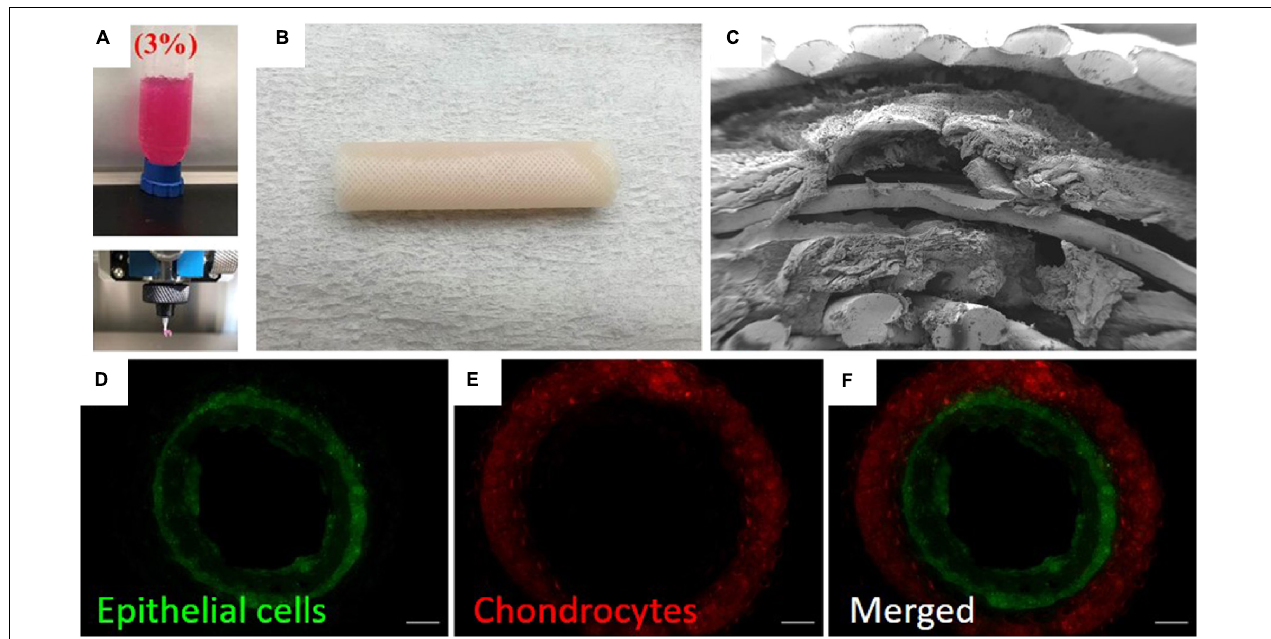
FIGURE 6 | Example of 3D printing process for construction of tissue engineered trachea (Park et al., 2019). (A) Image showing 3D printing of alginate into a cell-compatible hydrogel. (B) Image of 3D printed trachea. Scaffold consisted of 5 layers (innermost to outermost): gridded pattern of poly(capralactone), alginate hydrogel containing primary nasal epithelial cells, cylindrical pattern of poly(capralactone), alginate hydrogel containing primary auricular chondrocytes, gridded pattern of poly(capralactone). (C) SEM image showing lamellar structure of scaffold. (D–F) Fluorescence microscopy images showing stratified cell layers in scaffold cross-section. Epithelial cells are shown in green, and chondrocytes are shown in red. Images were reordered from multiple panels, and lettering has been relabeled for consistency as part of this review article (Park et al., 2019). These images are reprinted under Creative Commons Attribution 4.0 International License, available at